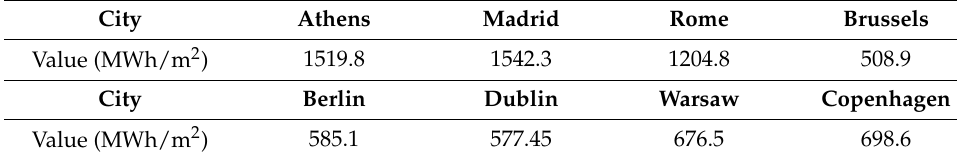
Table 1. Annual direct normal irradiance for a number of European cities.